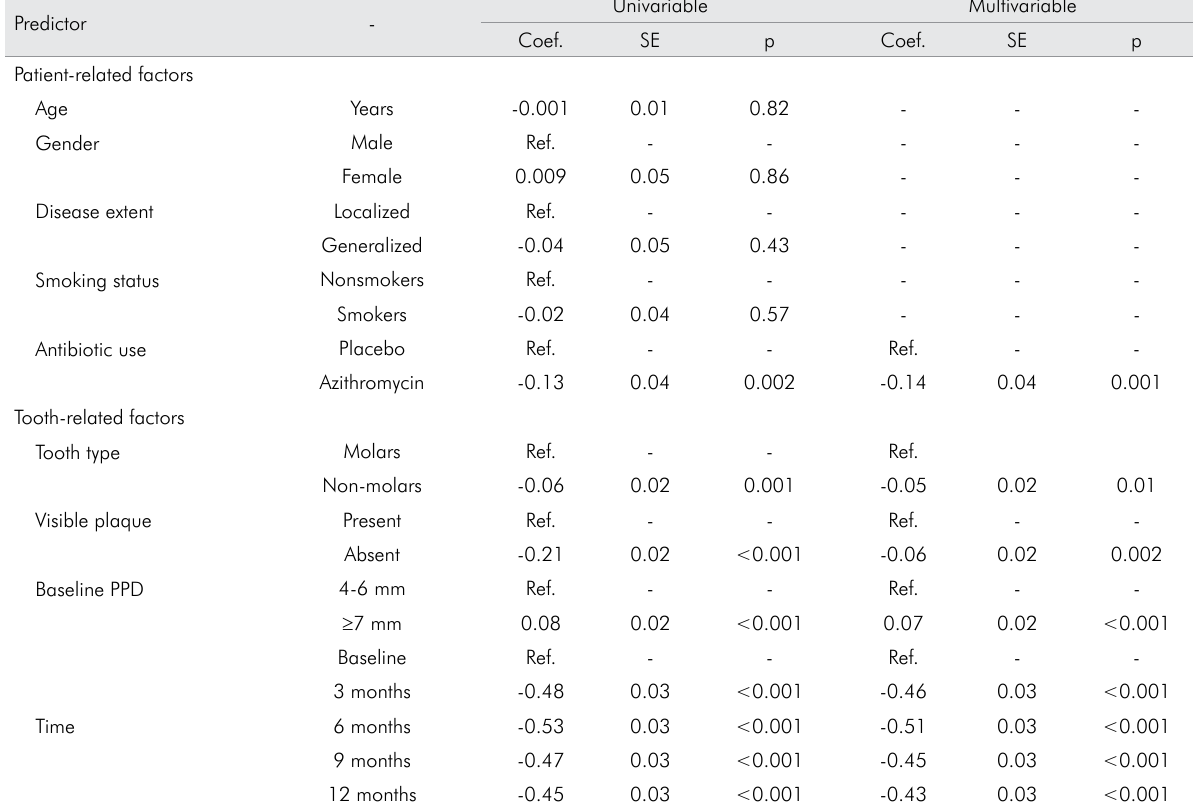
Table 4. Univariable and multivariable prediction models of BOP change over 12 months.